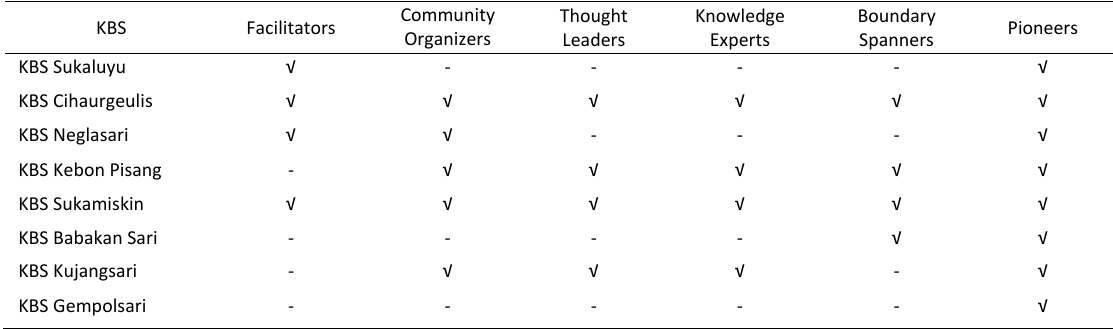
Table 3: Leadership existence in every KBS